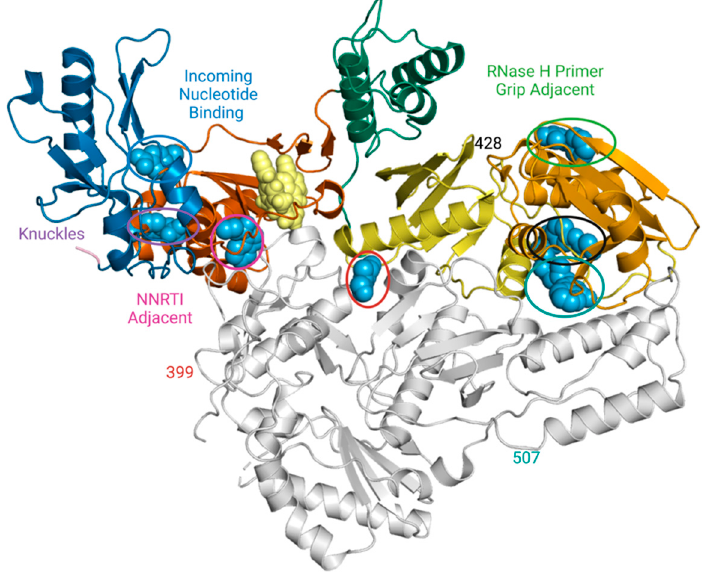
Figure 1. Overview of fragment hit locations in newly identified sites by Bauman et al. [7]. Legend: HIV-1 RT p66 subunit with fingers (blue), palm (red), thumb (green), connection (yellow) and RNase H (orange); p51 shown in gray; rilpivirine bound to the NNRTI-binding pocket (NNIBP) is shown as yellow spheres; bound fragments are shown as cyan spheres. Each binding site is circled and color coded according to its name (i.e., purple corresponds to Knuckles). Site, compound, and potency information in Table S1. Created with PyMOL and BioRender.com.